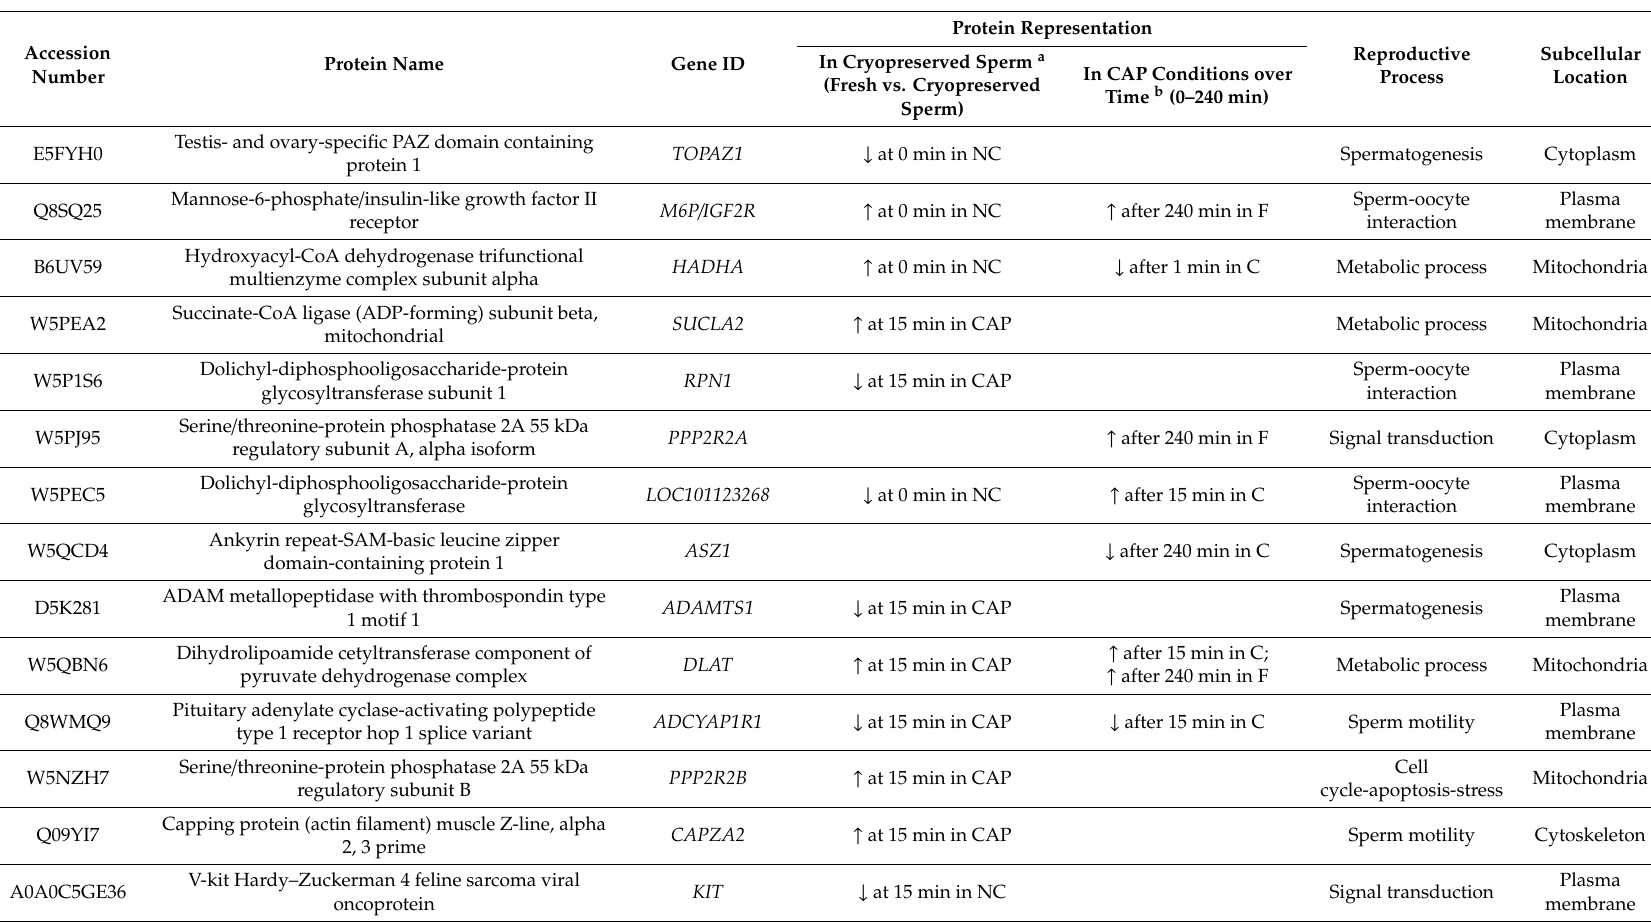
Table 3. Di ff erentially abundant proteins ( p < 0.05) in fresh (F) and cryopreserved (C) ram sperm incubated in CAP or NC conditions at di ff erent incubation